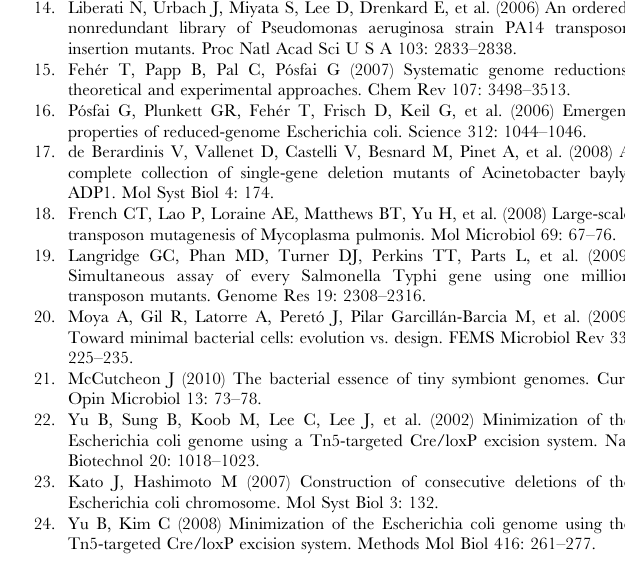
Figure S2 Genetic organization of essential genes. Figure shows the genetic organization of the chosen B. cenocepacia essential genes and their flanking regions. The black arrows indicate the locations of the inserted rhamnose-inducible promoter. Figure S3 Control growth curves. Growth curves of the